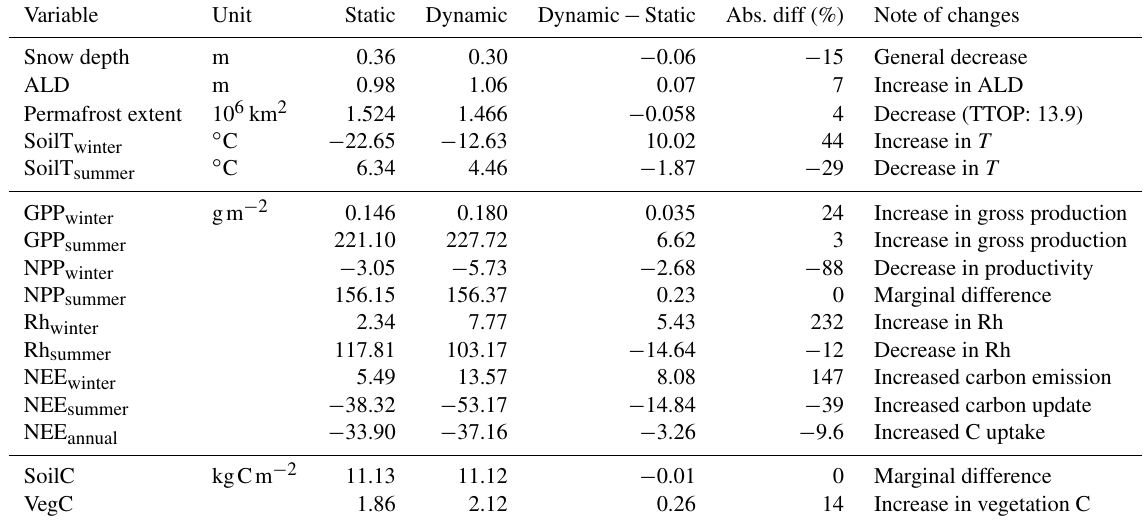
Table 2. Pan-arctic mean values for the studied variables for the Static and Dynamic simulations and their respective differences. Variable Unit Static Dynamic Dynamic − Static Abs. diff (%) Note of changes Snow depth m 0.36 0.30 General decrease ALD SoilT winter